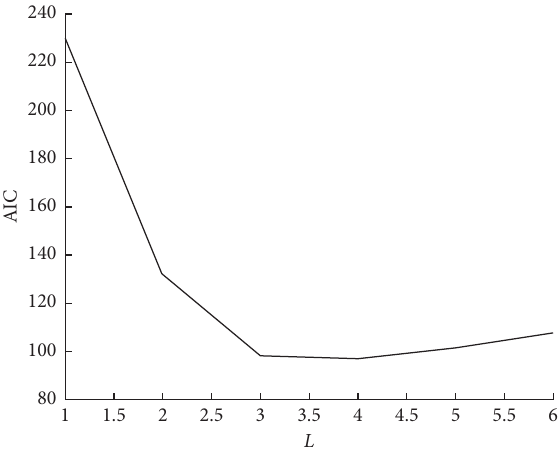
Figure 7: Calculation results of the AIC. Table 3: The total energy of each IMF and the correlation coefficient.